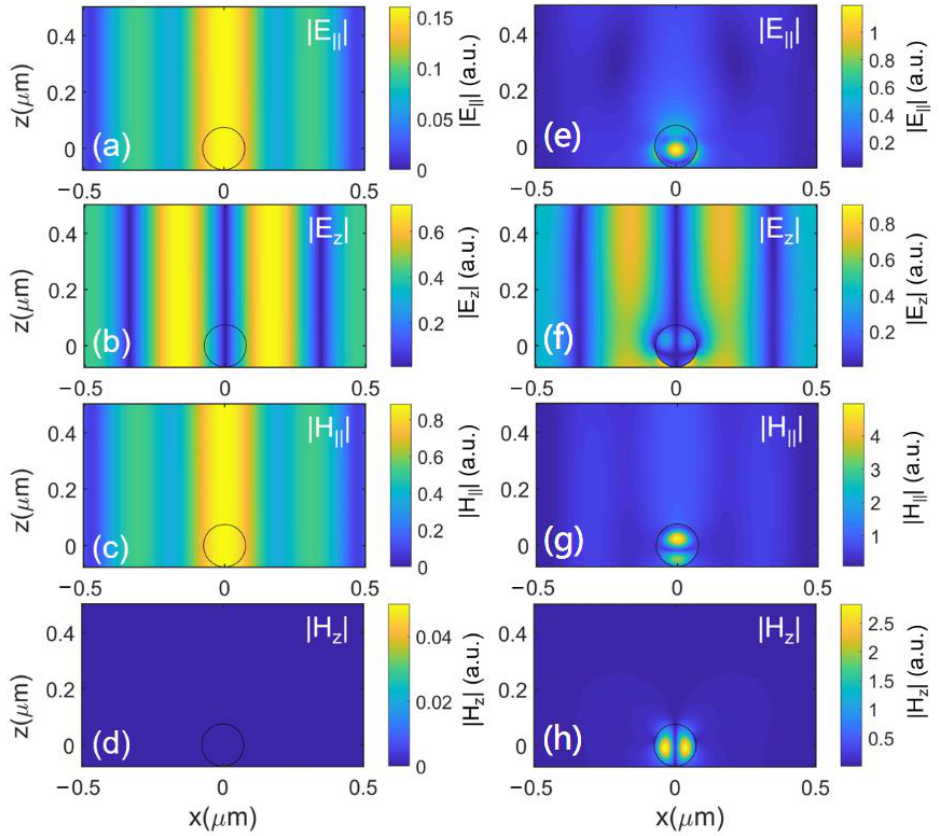
Figure 5. The light field of the vectorial Bessel beam above the air–dielectric interface. The topological charge is m 0 = 1. ( a – d ) The distributions of E || , E z , H || , and H z without the chiral sphere. E || and E z ( H || and H z ) represent the electric (magnetic) field components parallel and vertical to the interface. ( e – h ) The distributions of E || , E z , H || , and H z scattering by the chiral sphere. The incident light frequency is 546 THz.